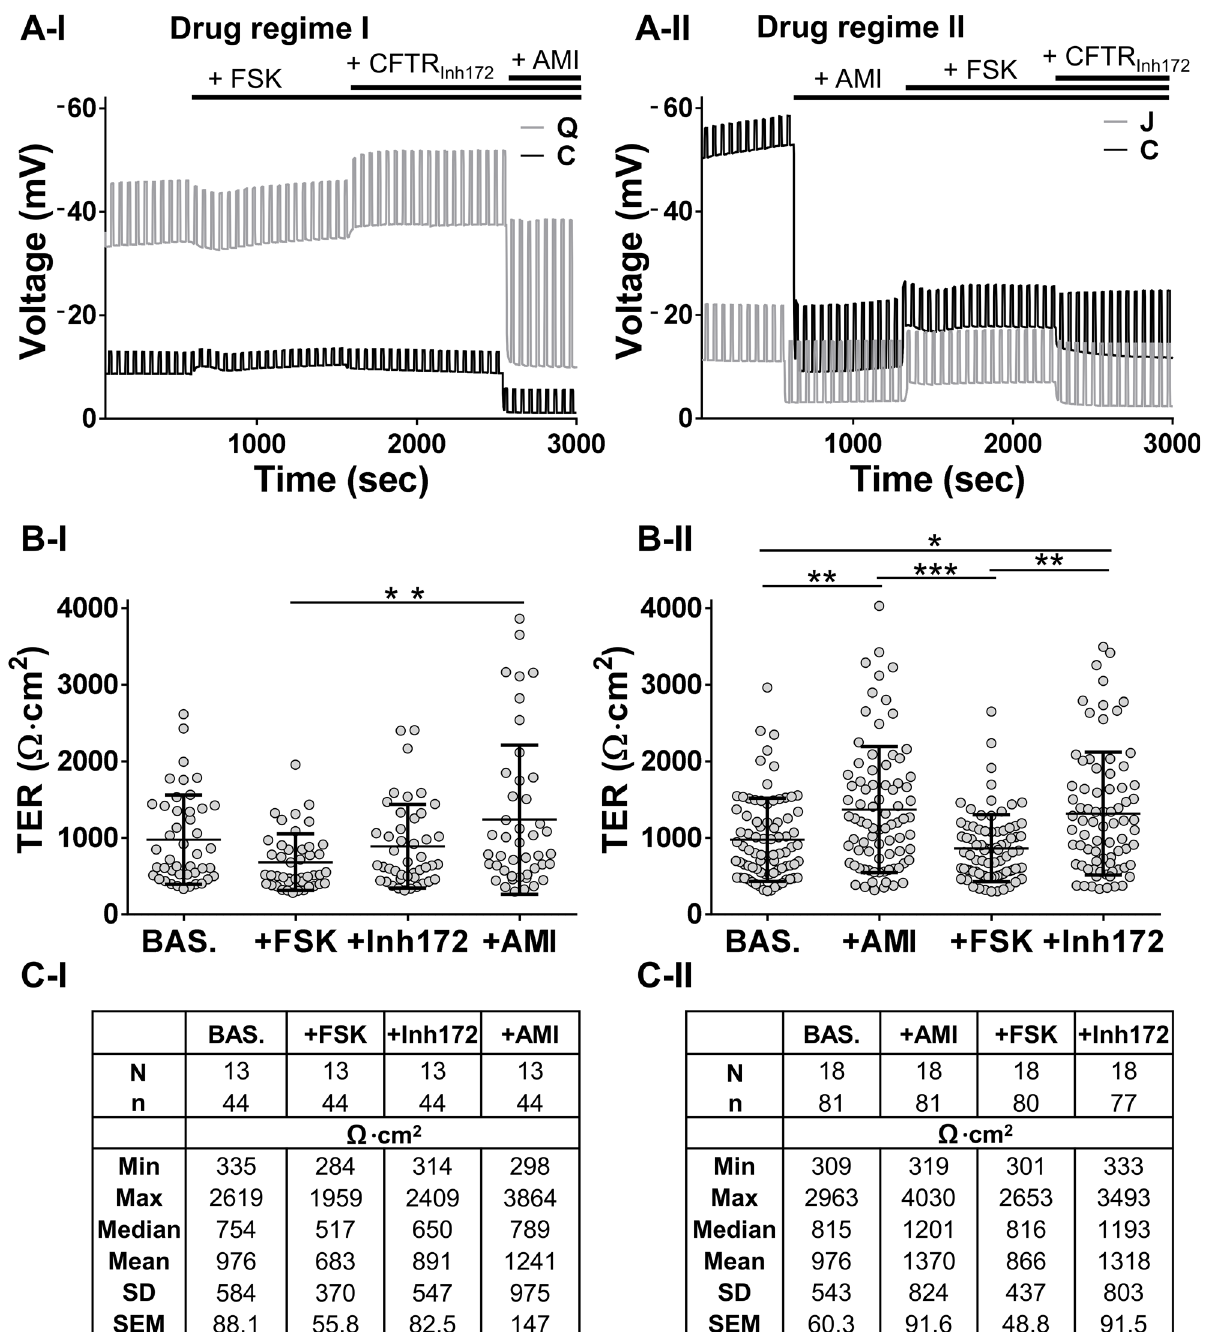
Fig 4. Ussing chamber ion transport analysis. (A-I, A-II) Two different drug regimes (I and II) were used and typical representative traces from two donors each are shown. (B-I, C-I) TER values obtained applying drug regime I with their Table of basic statistical analysis. Similarly (B-II, C-II) show the data obtained applying drug regime II. Error bars: mean ± SD; Kruskal-Wallis ANOVA + Dunn ’ s multiple comparison test: * P < 0.05; ** P < 0.01, *** P <